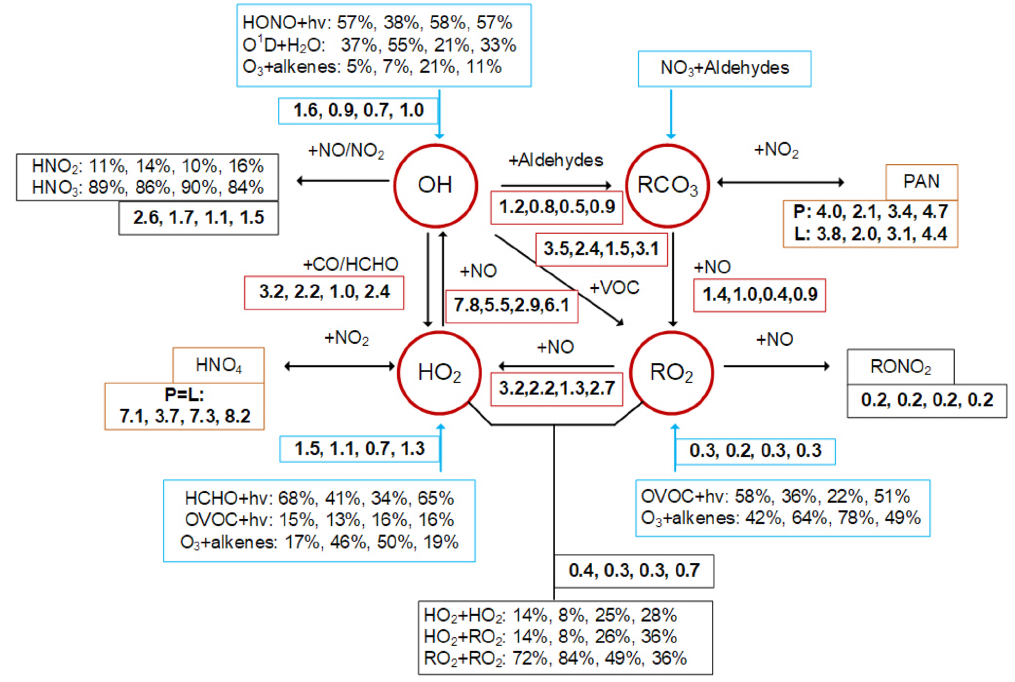
Figure 8. Comparison of the OH–HO 2 –RO 2 radical budget in four cities under daytime conditions (06:00 to 18:00LT). The numbers are sorted from left to right in the order of Beijing, Shanghai, Guangzhou, and Chongqing. The blue, black, red, and yellow boxes denote the primary radical sources, radical termination, radical propagation, and equilibrium between radicals and reservoir species, respectively.